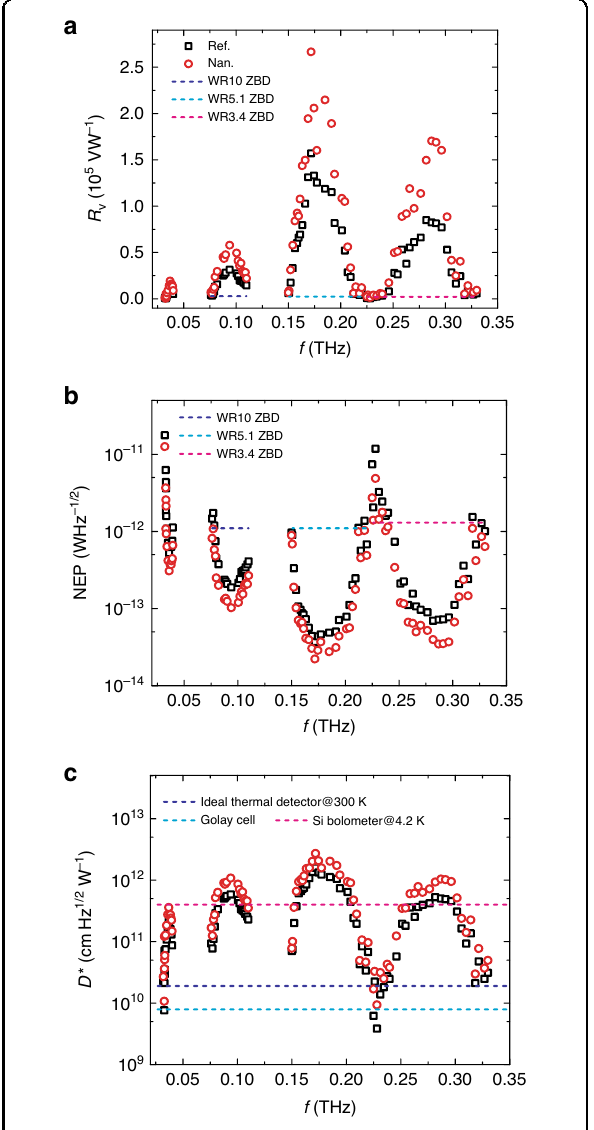
Fig. 4 Spectral response. R v ( a ), NEP ( b ), and D * ( c ) of the devices in a frequency range of 0.032 – 0.330 THz under a voltage bias of 1000 mV. The dash lines in a and b represent typical performance of state-of- the-art commercial zero-bias SBDs (ZBDs) from VDI for corresponding frequency band 59 . The dash lines in c represent the ideal D * of a thermal-type detector at room temperature, Golay cell and an Si bolometer at 4.2